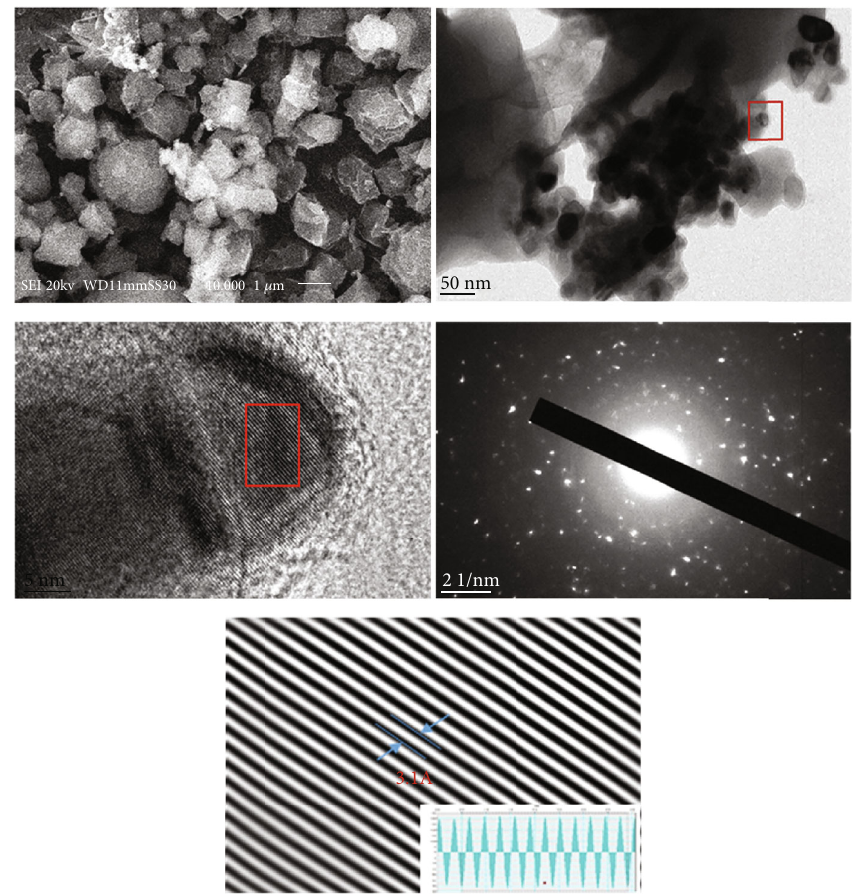
Figure 5: Morphological structures of the Zn-adeninate bio-MOF: (a) SEM and (b) TEM, HRTEM, fringe lattices, and